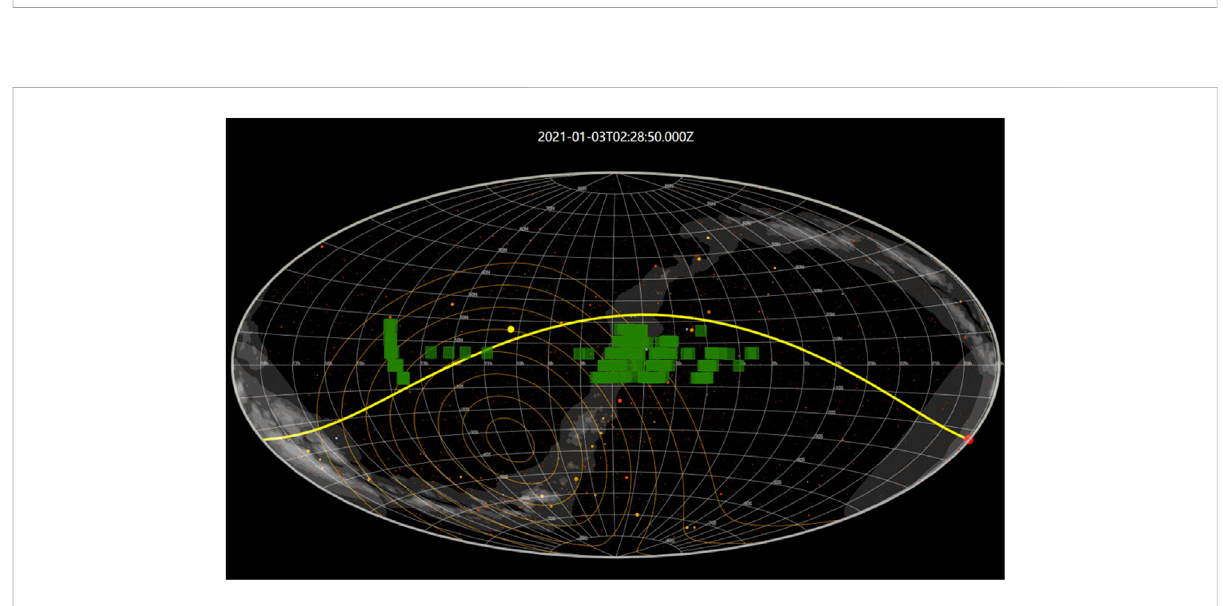
A sample surveyplan for CHES-SA. The green patches are fi eld ofview of thetelescope. The observation order is arranged bythemovement of twilight terminator and Moon. The survey region is typically fi ve belts around the equator with 6 ° wide based on the telescope